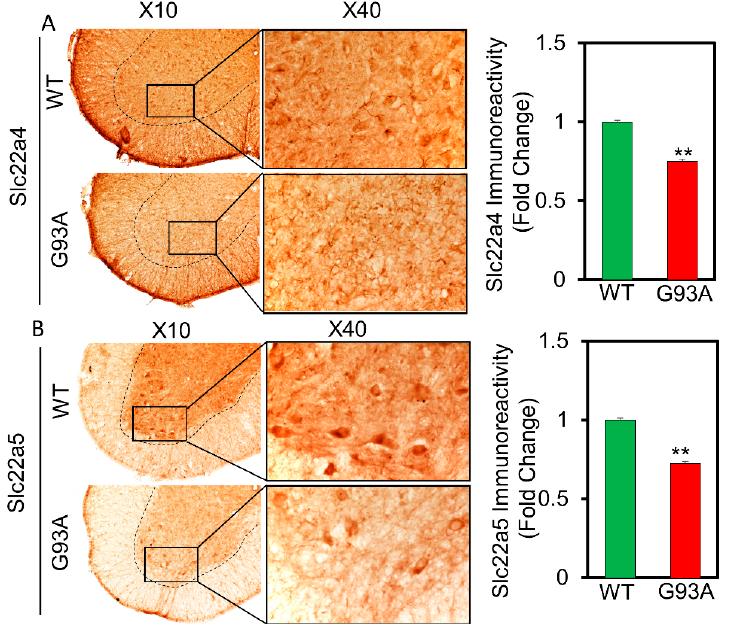
Figure 6. Carnitine transporters SLC22a4 ( A ) and SLC22a5 ( B ) immunoreactivity is decreased in motor neurons of the gray matter of spinal cord of ALS (G93A) mice ( n = 5) in comparison to WT littermate mice ( n = 5). Scale bar left: 100 μ m, right: 40 μ m. ** p < 0.01 significant difference from the WT mice.